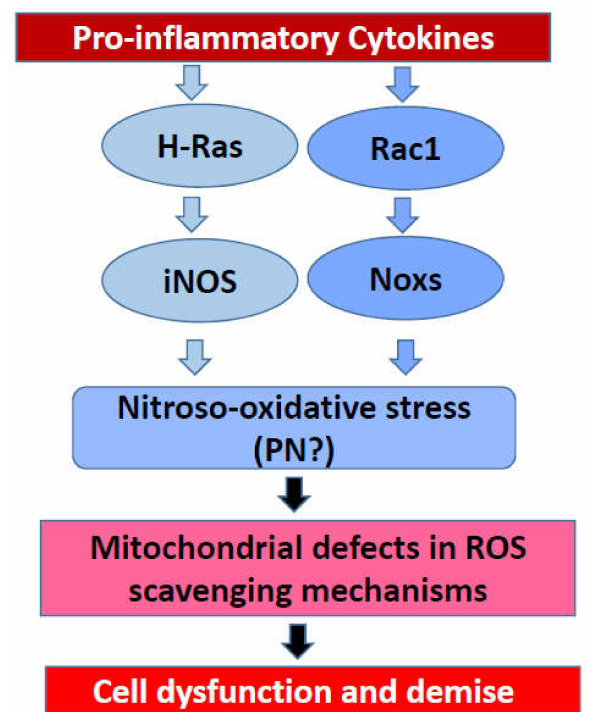
Figure 3. Potential involvement of small G proteins in cytokine-induced NO release and ROS formation leading to mitochondrial dysfunction and demise of the rat islet beta